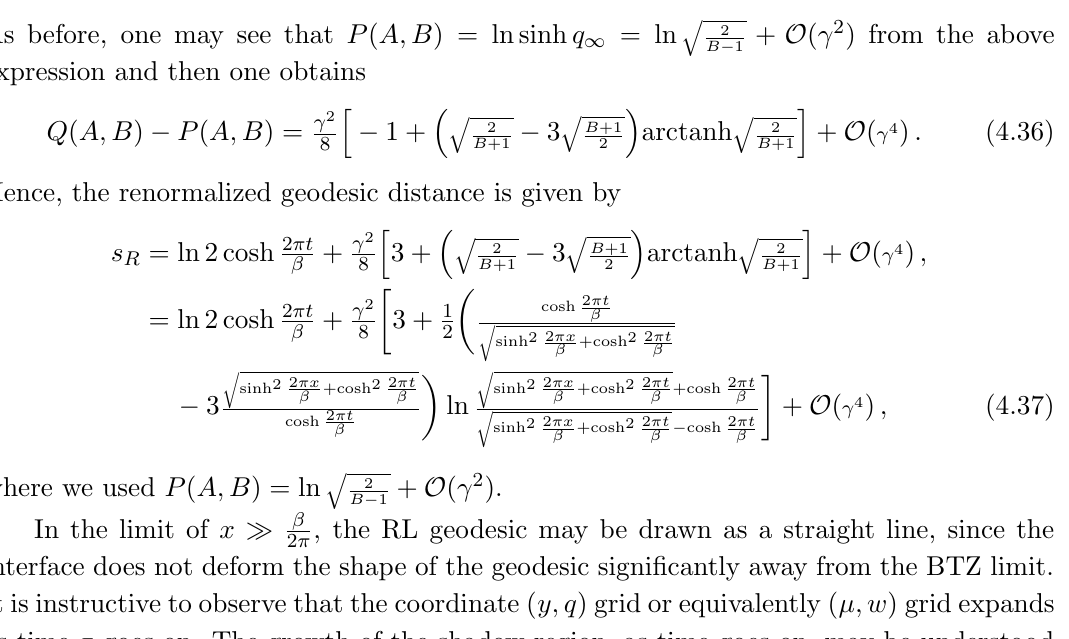
(cid:22) I takes nearly the same form (cid:6)